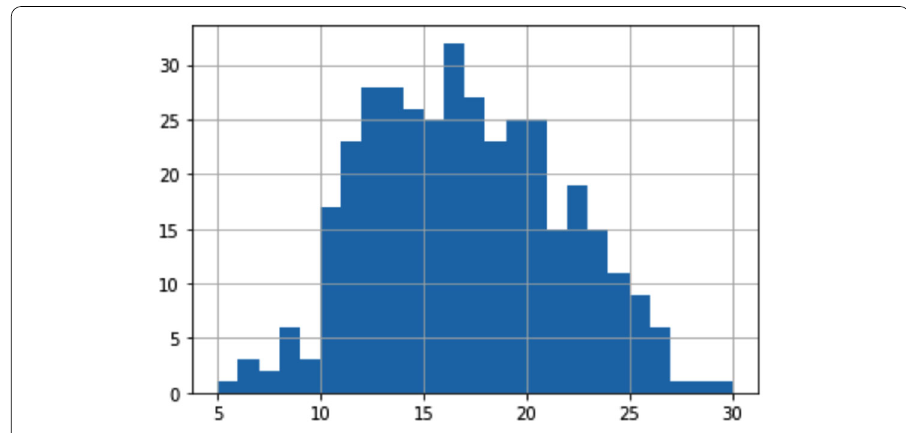
Figure 2 Distribution of WHO-5 values